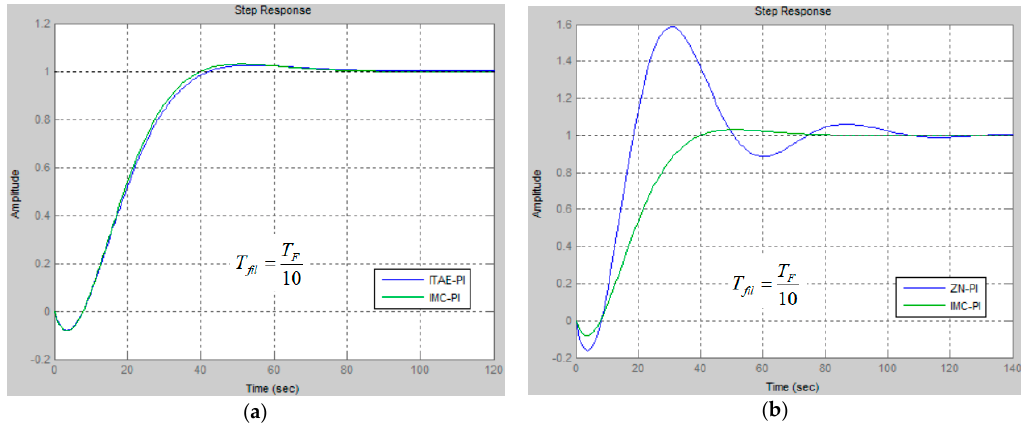
Figure 7. The indicial responses with PI controllers: ( a ) IMC and Integral of Time Multiplied by Absolute Error (ITAE); ( b ) IMC and Ziegler–Nichols. Proceedings 2020 , 63 , 34